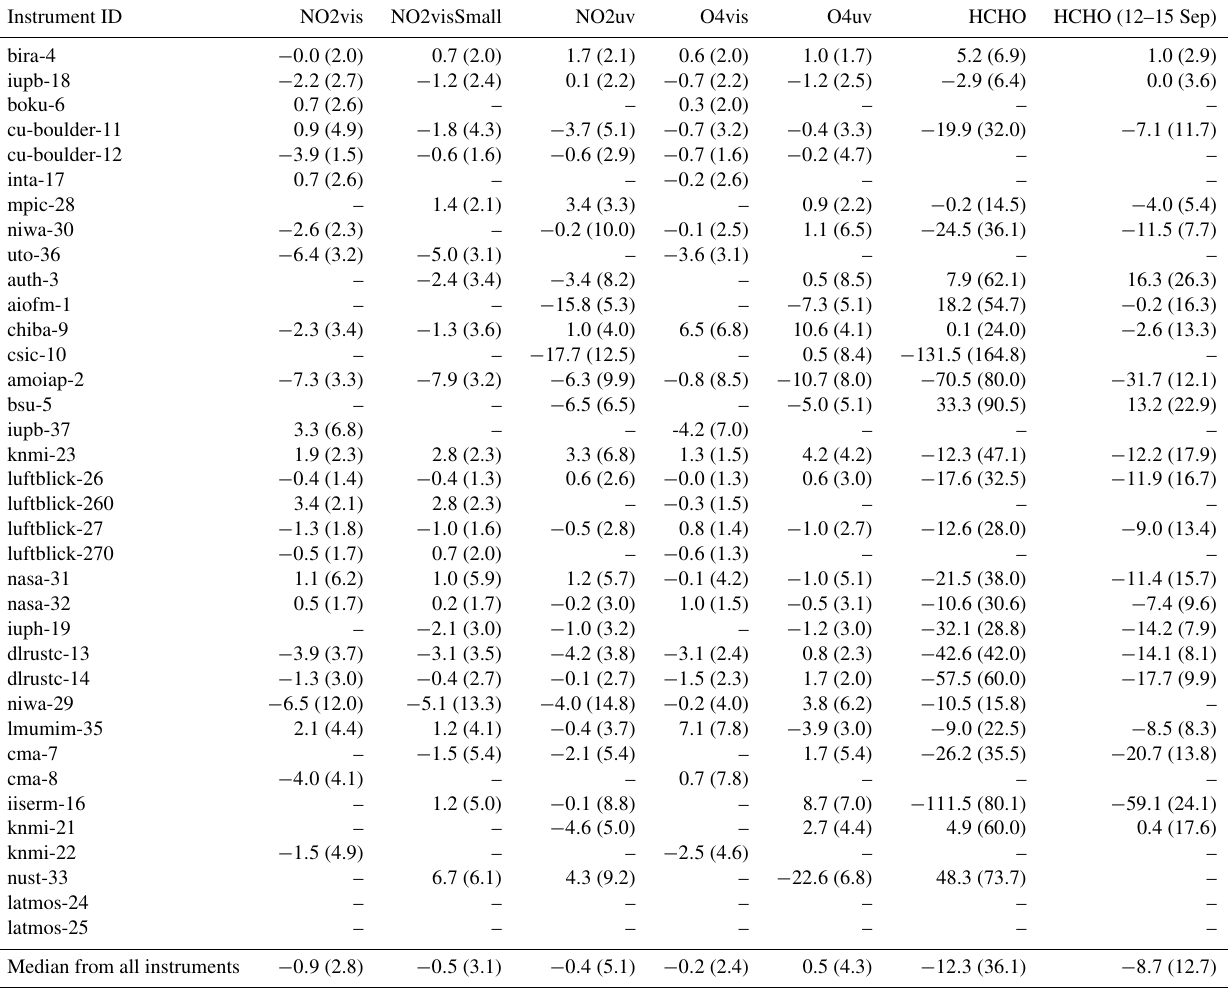
Table 5. Mean relative difference from the reference and standard deviation (in percent) for all participating instruments and MAX-DOAS data products (apart from ozone). The last column provides the values for HCHO when only considering measurements made during the first 4d of the campaign period (12–15 September